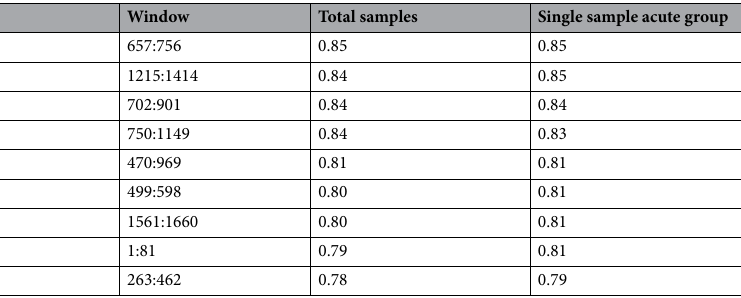
Table 5. Area under the receive operating characteristic curves for the differentiation of acute from chronic infections. Total samples are those AUC values obtained from analyses using the total samples from this dataset, whereas ’single sample acute group’ removes longitudinal data and retains the earliest acute and latest chronic samples of each